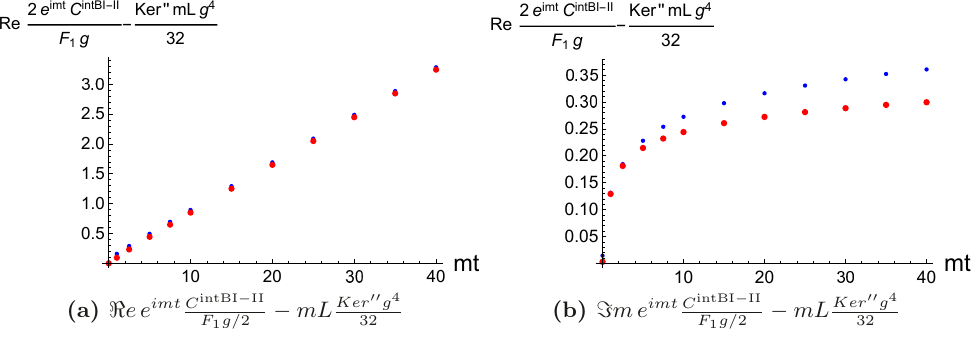
Figure 4. Real and imaginary parts of e imt C intBI − II for time instants mt = 0 . 1 , 1 , 2 . 5 , 5 , 7 . 5 , 10 , 15 , 20 , 25 , 30 , 35 and 40 for a quench in the Ising model. The orange and red symbols correspond to system sizes mL = 50 and 60. g = 1.